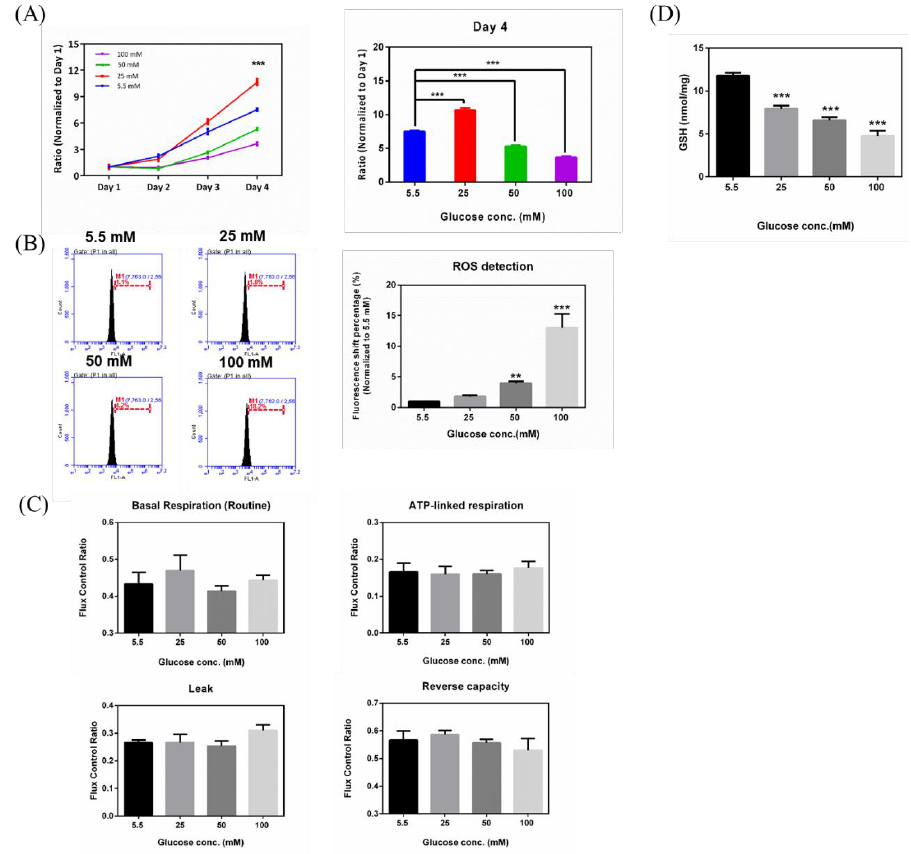
Figure 1. E ff ects of hyperglycemia on retinal ganglion cells (RGCs). ( A ) Left: Cell proliferation rates under di ff erent glucose concentrations were examined from Day 1 to Day 4 by cell viabilityassay. The data from Day 2, Day 3, and Day 4 were normalized to Day 1. Right: Isolated Day 4 data to show the di ff erential proliferation rates in four glucose concentrations. Data are represented as mean ± SEM. ***, p < 0.001 when compared to the 5.5 mM group. ( B ) Left: Increased iROS (intracellular reactive oxygen species) accumulation in RGCs with hyperglycemia. Intracellular reactive oxygen species (ROS) contents were determined by the aminophenyl fluorescein (APF) assay on RGC-5 cell cultures at di ff erent glucose concentrations (5.5 mM, 25 mM, 50 mM, and 100 mM glucose) for the duration of 3 weeks. After exposure, 106 cells were stained with diluted APF (5 µ M). Intracellular ROS generation was quantified by flow cytometry. Right: Relative fluorescence shift percentage was quantified and normalized to the 5.5 mM group. Data are represented as mean ± SEM. **, p < 0.01; and ***, p < 0.001 when compared to 5.5 mM group. ( n = 3) ( C ) The oxygen consumption rate (OCR) of RGCs with hyperglycemia in order of Basal respiration (routine), ATP-linked respiration, Leak, and Reverse capacity. Data are represented as means ± SEM. ( n = 3) ( D ) Measurement of GSH content in RGCs with hyperglycemia. Dose responses involving total GSH (Glutathione) levels in cells treated with 5.5 mM, 25 mM, 50 mM, and 100 mM glucose medium were assayed. Data are represented as means ± SEM. ***, p < 0.001 when compared to the 5.5 mM group. ( n = 3).